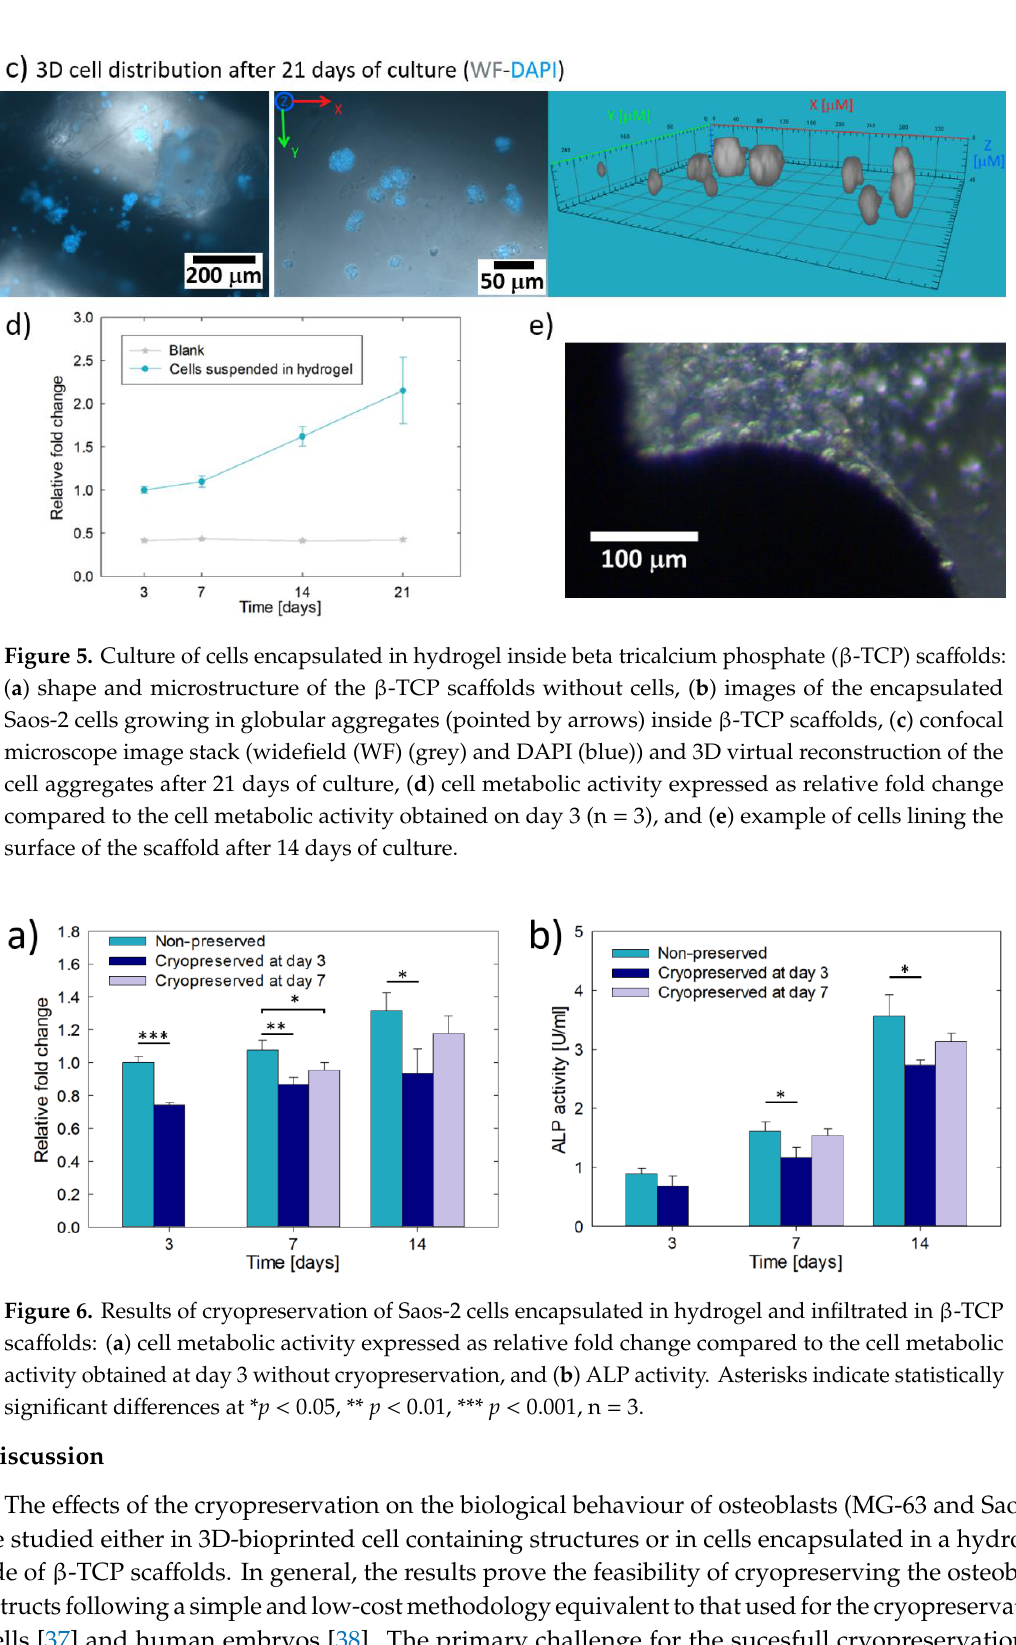
Figure 5. Culture of cells encapsulated in hydrogel inside beta tricalcium phosphate ( β -TCP) scaffolds: ( a ) shape and microstructure of the β -TCP scaffolds without cells, ( b ) images of the encapsulated Saos- 2 cells growing in globular aggregates (pointed by arrows) inside β -TCP scaffolds, ( c ) confocal microscope image stack (widefield (WF) (grey) and DAPI (blue)) and 3D virtual reconstruction of the cell aggregates after 21 days of culture, ( d ) cell metabolic activity expressed as relative fold change compared to the cell metabolic activity obtained on day 3 (n = 3), and ( e ) example of cells lining the surface of the scaffold after 14 days of culture.